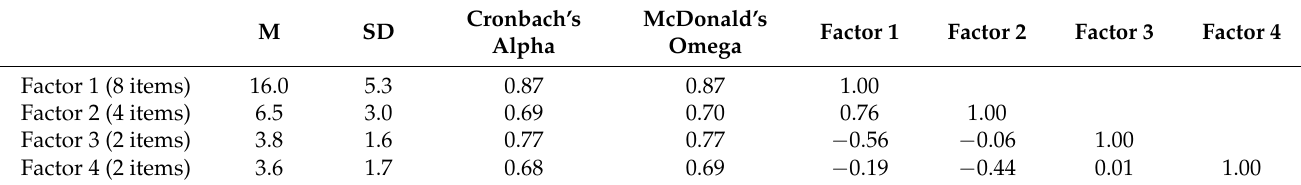
Table 2. Means, standard deviations, reliability and HBS-16 factor correlation matrix ( p <